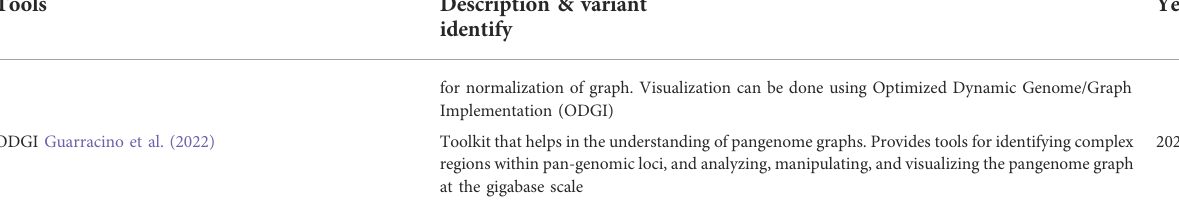
TABLE 1 ( Continued ) List of pangenome applications and pipelines with brief